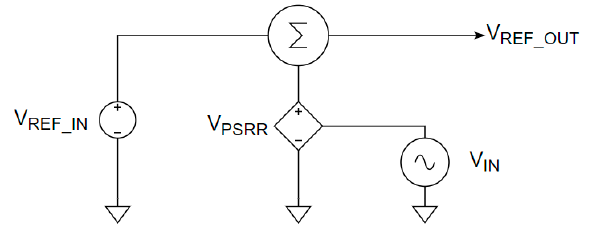
Figure 10. New LDO PSRR model concept.